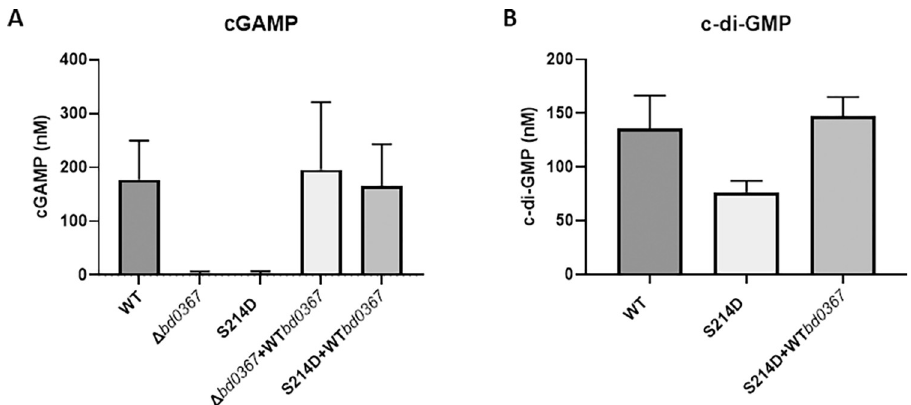
Fig 3. Cyclic nucleotide levels in B . bacteriovorus . A- cGAMP was extracted from whole B . bacteriovorus cells of wild type HID22 (WT), mutants Δ bd0367 and S214D, or complemented mutants ( Δ bd0367 +WT bd0367 and S214D+WT bd0367 ) and quantified using HPLC-MS/MS. Means and standard deviations of three biological replicates are presented. Cyclic GAMP levels in the complemented mutants were not significantly different from wild- type ( p = 0.9976 for Δ bd0367 +WT bd0367 and p = 0.9997 for S214D+WT bd0367 by one-way ANOVA and Tukey’s multiple comparison test). B- c-di-GMP was extracted from whole B . bacteriovorus cells of wild type HID22 (WT), mutant S214D, or complemented mutant S214D+WT bd0367 and quantified using HPLC-MS/MS. Means and standard deviations of three biological replicates are presented. Cyclic-di-GMP levels were not significantly different from wild-type ( p = 0.0857 for S214D and p = 0.8326 for S214D+WT bd0367 by one-way ANOVA and Tukey’s multiple comparison